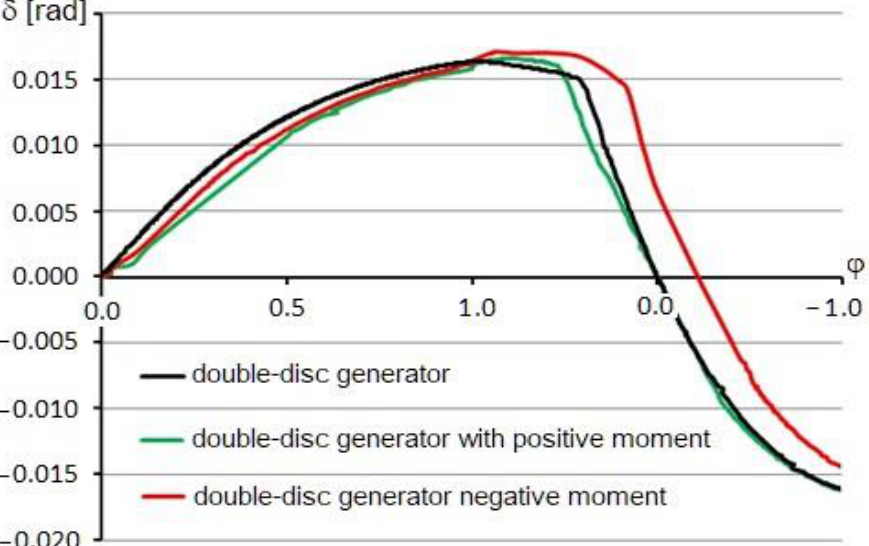
Figure 14. Rotation angle of circular spline resulting from double-disc generator work.